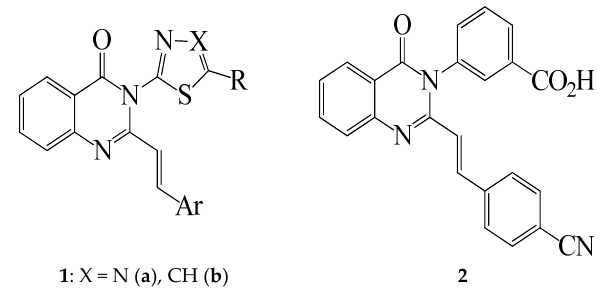
Figure 1. 3-substituted 2-styrylquinazolin-4(3 H )-ones 1 and 2 with antimicrobial activity.